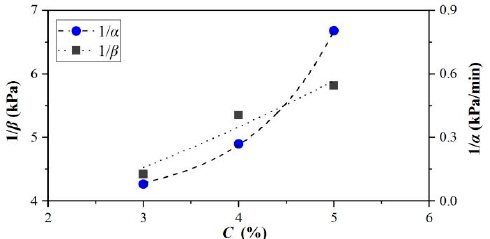
Figure 9. Relationship between 1/ α , 1/ β , and concentration.